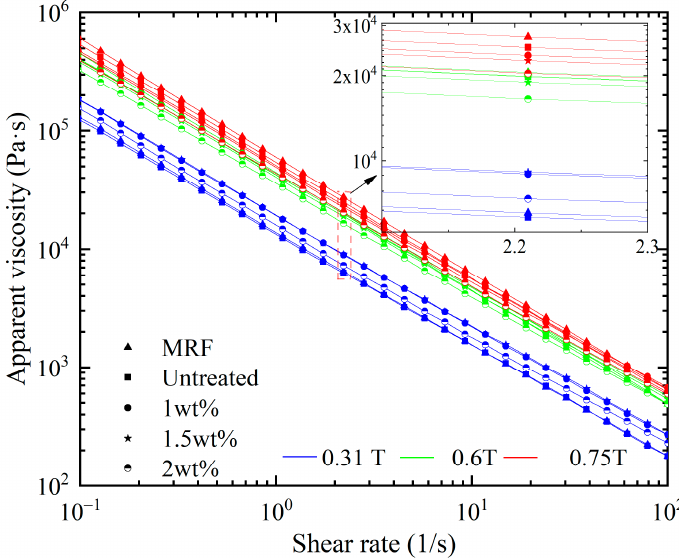
Figure 5. Variation of viscosity with shear rate under different magnetic flux densities.